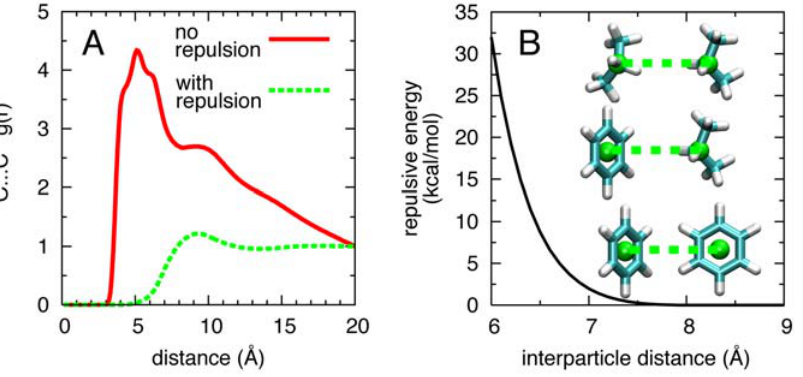
Figure 1. Effect of repulsive interactions between pairs of fragment molecules. (A) Carbon…carbon (C…C) radial distribution functions g ( r ) for an aqueous solution containing 1 M propane and 1 M benzene with and without a repulsive intermolecular interaction. (B) Location of repulsive interaction energy sites on propane and benzene molecules (spheres), and the interaction energy profile between two repulsive interaction energy sites.